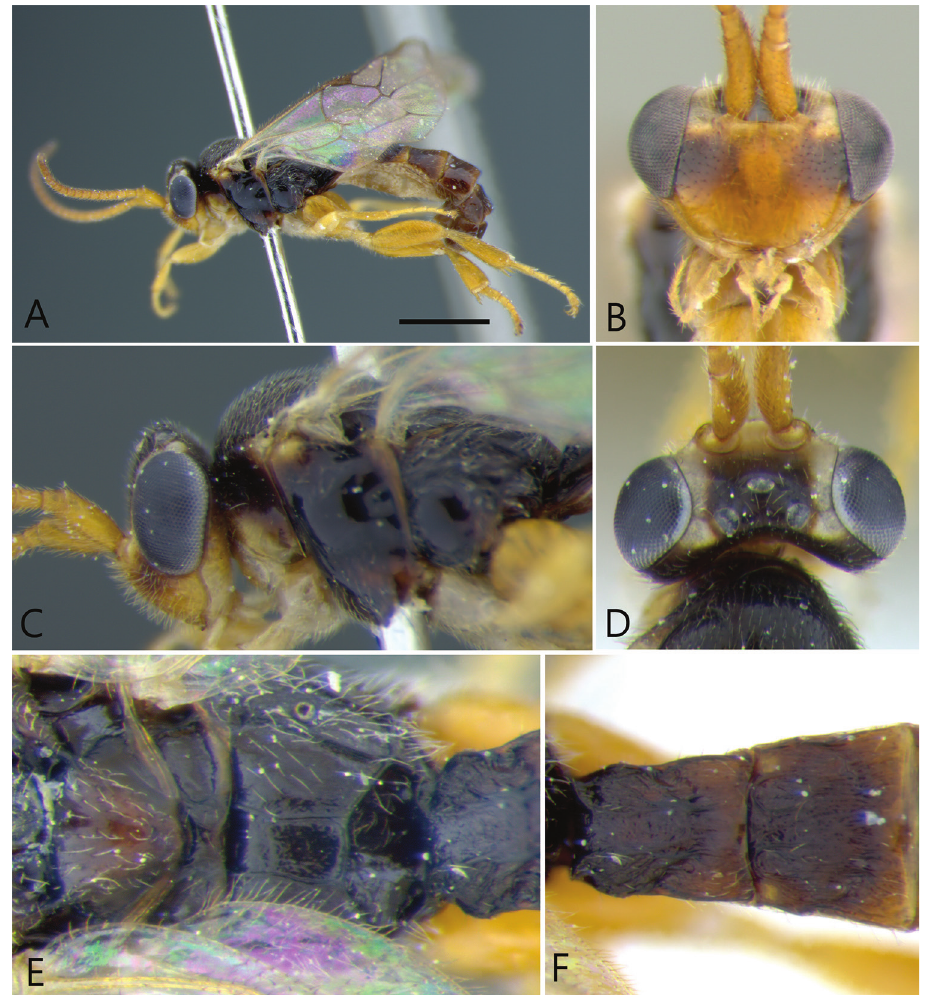
Figure 2. Orthocentrus brachycerus sp. nov. Holotype. A Habitus in lateral view B head in frontal view C head and mesosoma in lateral view D head in dorsal view E scutellum and propodeum in dorsal view F first and second tergites in dorsal